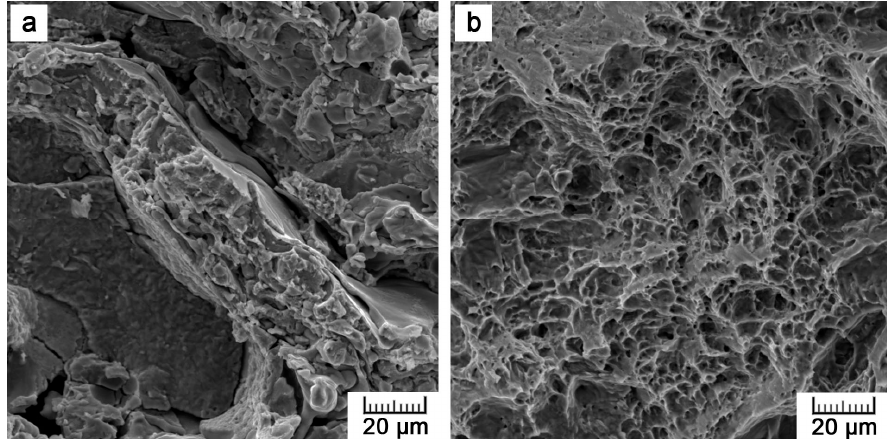
Figure 7. Fractured sample after the bending test: ( a ) plasma-sprayed Ti and ( b ) Ti wire .